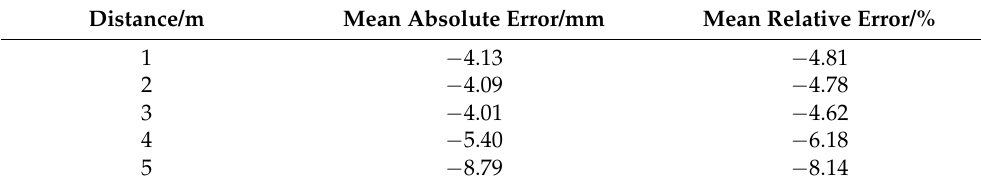
Table 5. Average Diameter Measurement Error at Various Distances.